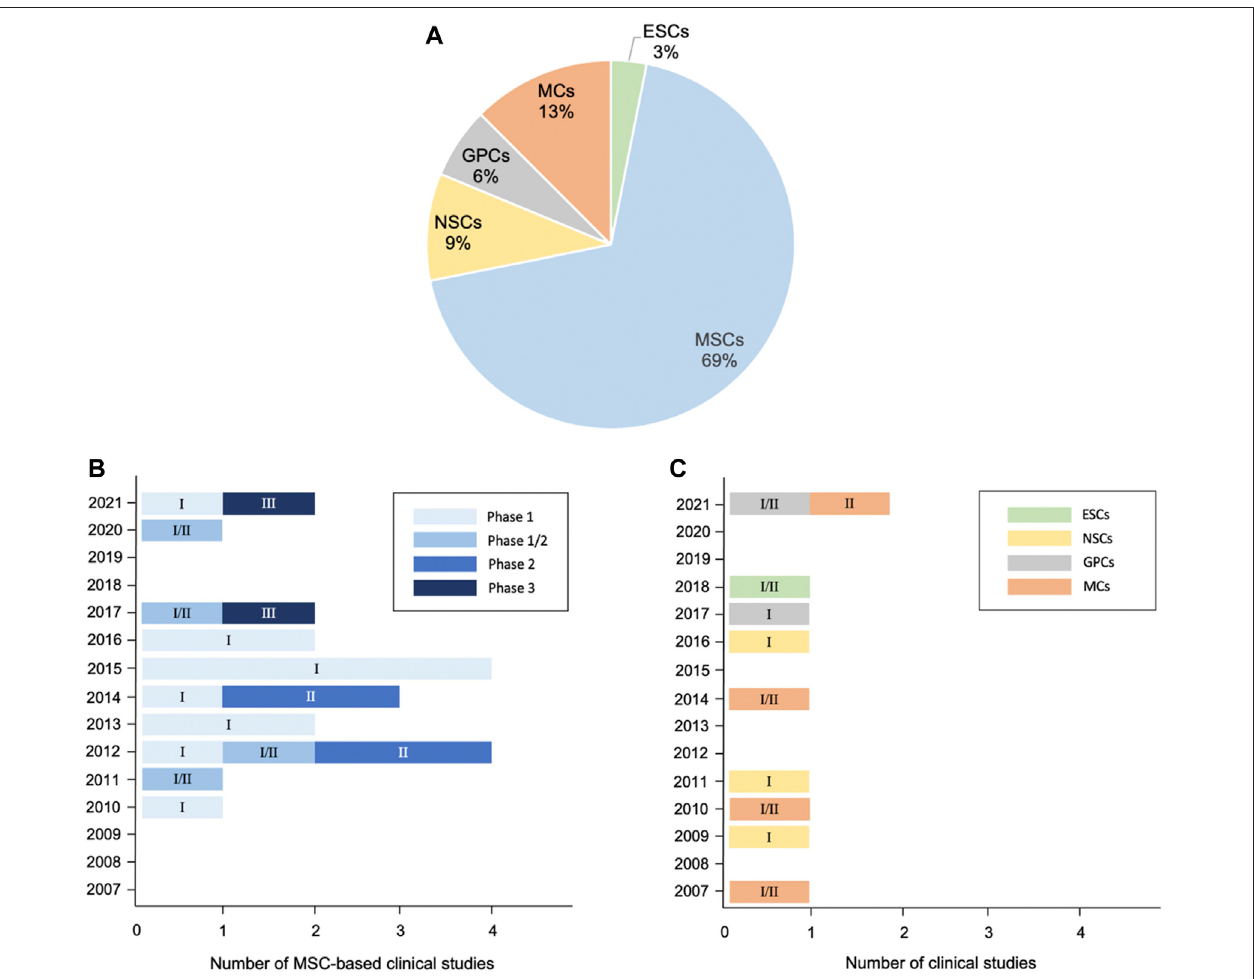
FIGURE 3 | Distribution of cellular therapy for ALS in clinical trials from 2007 to 2021. (A) Pie chart: analysis of cell types. (B) Trends of MSC-based applications regarding clinical phase. (C) Trends of ESC-, neural precursor cell-, and MC-based applications regarding clinical phase. 32 clinical trials have been registered as of October 2021, excluding studies with suspended, temporarily not available, terminated, withdrawn, available, and no longer available status according to clinicaltrials. gov. Numbers in the bars of Figures 3B,C indicate the corresponding phase of clinical trials.